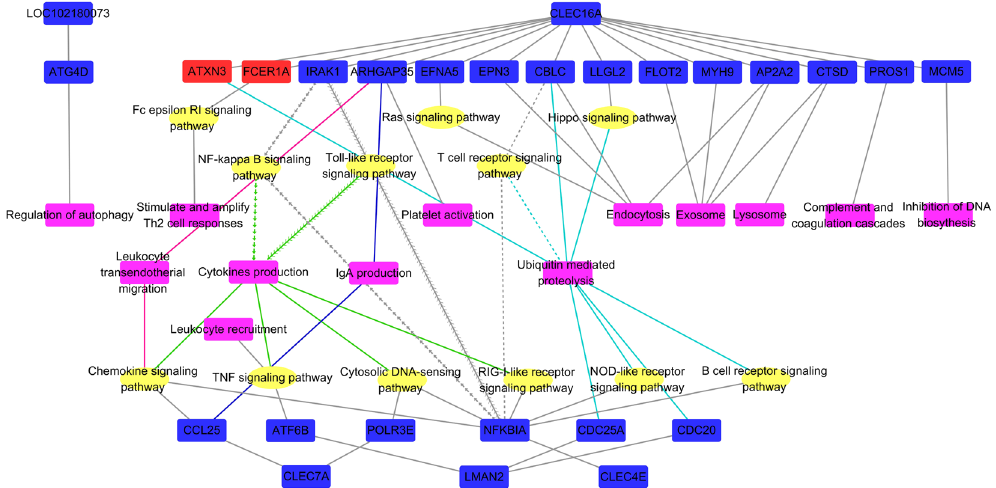
Figure 3. Regulation network of the lectin genes related to immune activities. The functions of the first neighbors were predicted by KEGG pathway analysis. Genes that show positive correlation with the 35% concentrate feeding are in red, and the genes that show negative correlation with the 35% concentrate diet are in blue. Signaling pathways are in yellow, and regulatory functions are in violet. The genes regulating the same signaling pathways are given the same line shapes and the genes and signaling pathways regulating the same functions are given the same